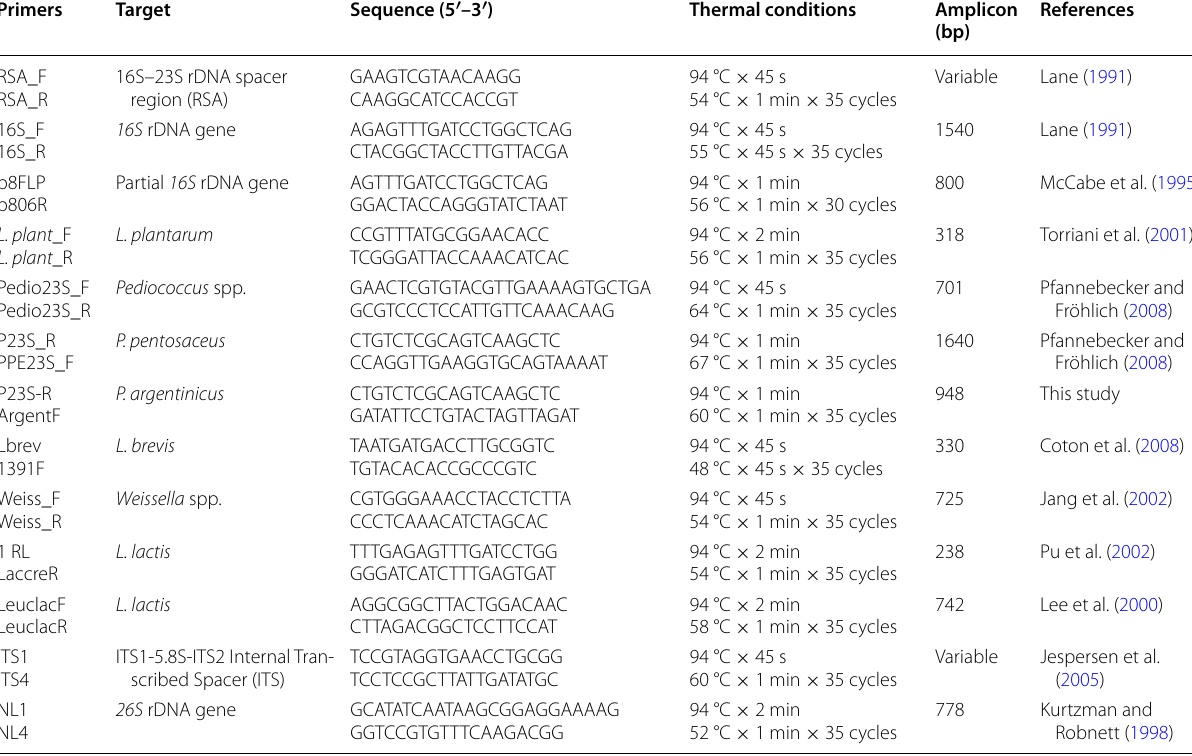
Table 1 PCR primers and conditions used for isolates identification